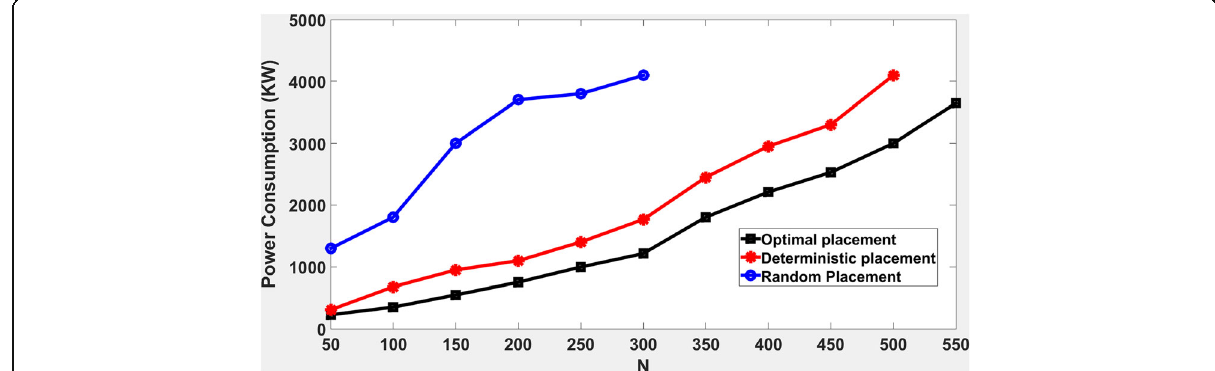
Fig. 6 Optimal, deterministic and random heuristic power consumptions as a function of the number of jobs in the system for random server power consumption